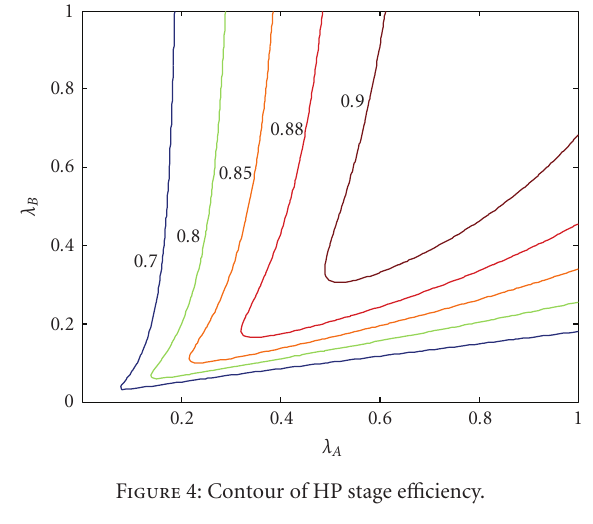
Figure 4: Contour of HP stage e ffi ciency.